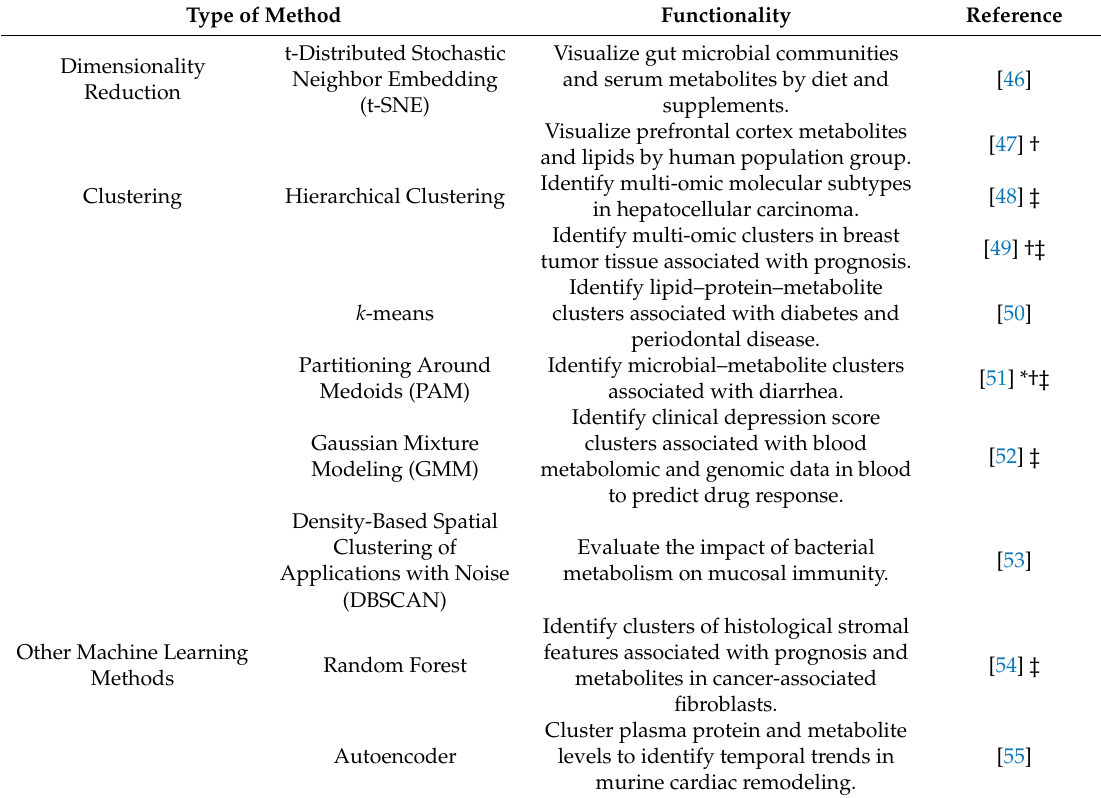
Table 1. Examples of multi-omics applications using unsupervised